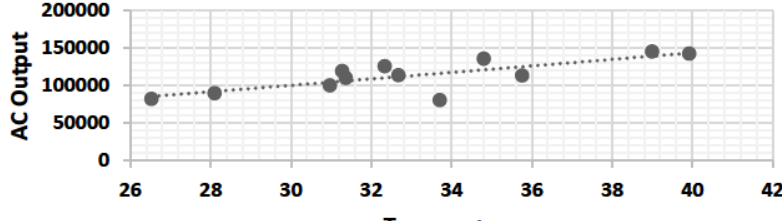
Figure 2: Polynomialisation of Temperature vs. AC Output Curve